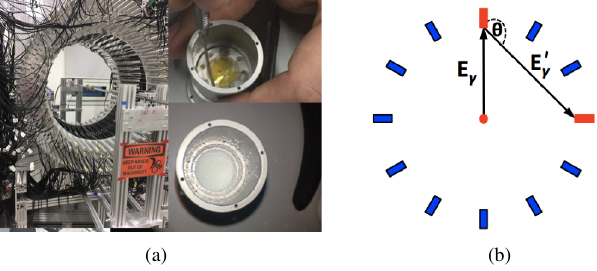
Figure 1. Left panel shows the J-PET prototype with 3 layers along with the placement of small chamber at the center of detector with 22 Na source inside surrounded by XAD4 porous material. Right panel shows the schematic of the photon’s interaction with scintillator and the corresponding scattering angle θ